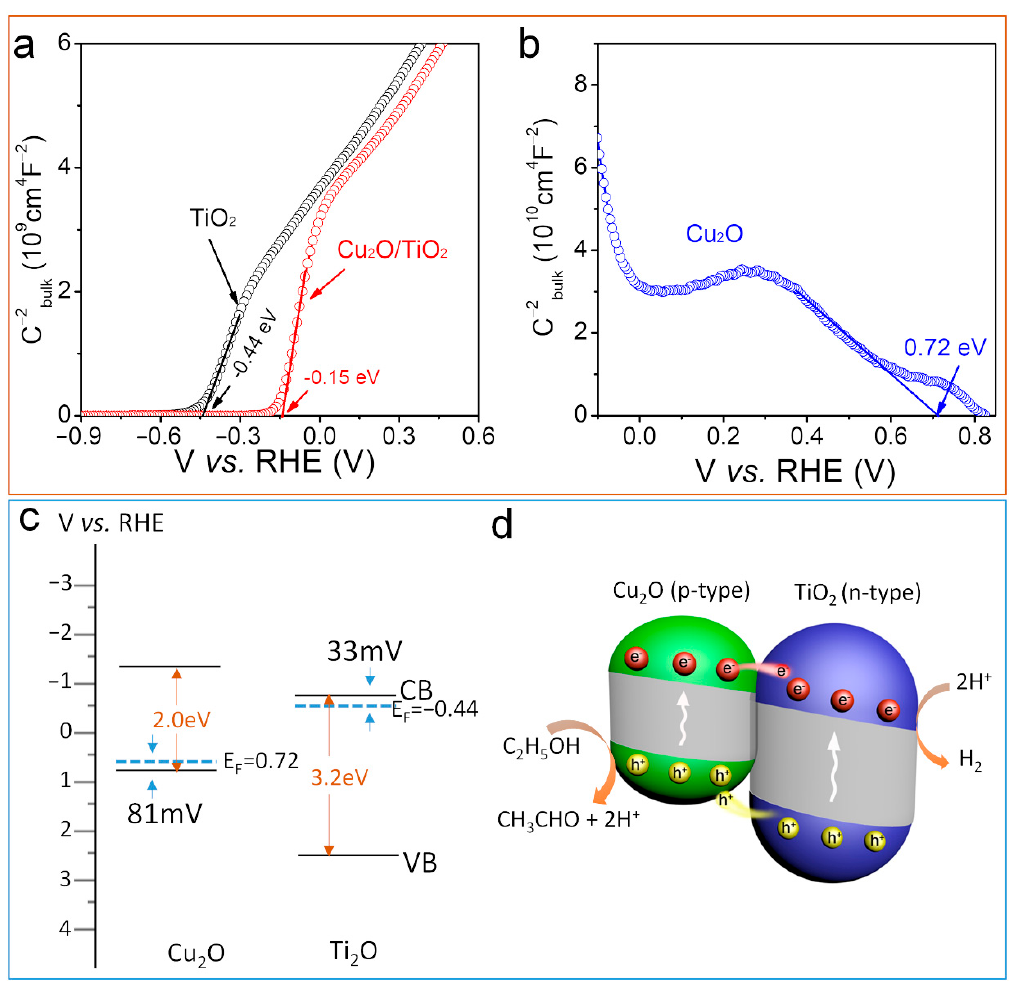
Figure 5. ( a ) M-S analysis of TiO 2 and 1% Cu 2 O/TiO 2 . ( b ) M-S analysis of a Cu 2 O. ( c ) Energy band diagrams for Cu 2 O and TiO 2 before contact. ( d ) Scheme of the Energy band structure of a Cu 2 O/TiO 2 heterojunction and the ethanol dehydrogenation reaction.